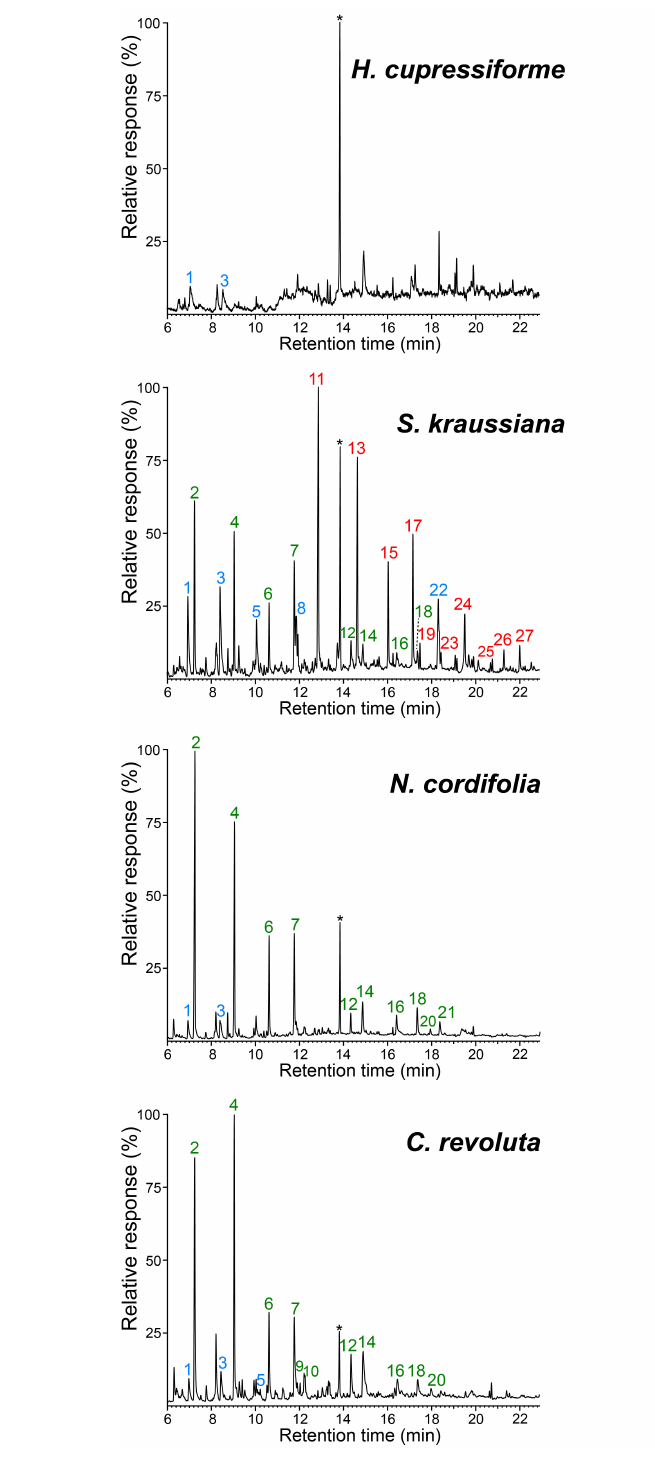
FIGURE 2 | Pyrograms of the lignin-like fractions isolated from the eight ancestral plants studied. Phenolic markers of H, G, and S lignin units are labeled in blue, green and red, respectively. Peaks identities: phenol (1), guaiacol (2), 4-methylphenol (3), 4-methylguaiacol (4), 4-ethylphenol (5), 4-ethylguaicol (6), 4-vinylguaicol (7), 4-vinylphenol (8), eugenol (9), 4-propylguaiacol (10), syringol (11), trans- isoeugenol (12), 4-methylsyringol (13), vanillin (14), 4-ethylsyringol (15), acetovanillone (16), 4-vinylsyringol (17), guaiacylacetone (18), 4-allylsyringol (19), propiovanillone (20), guaiacyl vinyl ketone (21), 4-hydroxyacetophenone (22), cis -4-propenylsyringol (23), trans -4-propenylsyringol (24), syringaldehyde (25), acetosyringone (26), and syringylacetone (27). *Solvent stabilizer 4-methyl-2,6-ditertbutylphenol (rt ∼ 13.8 min).